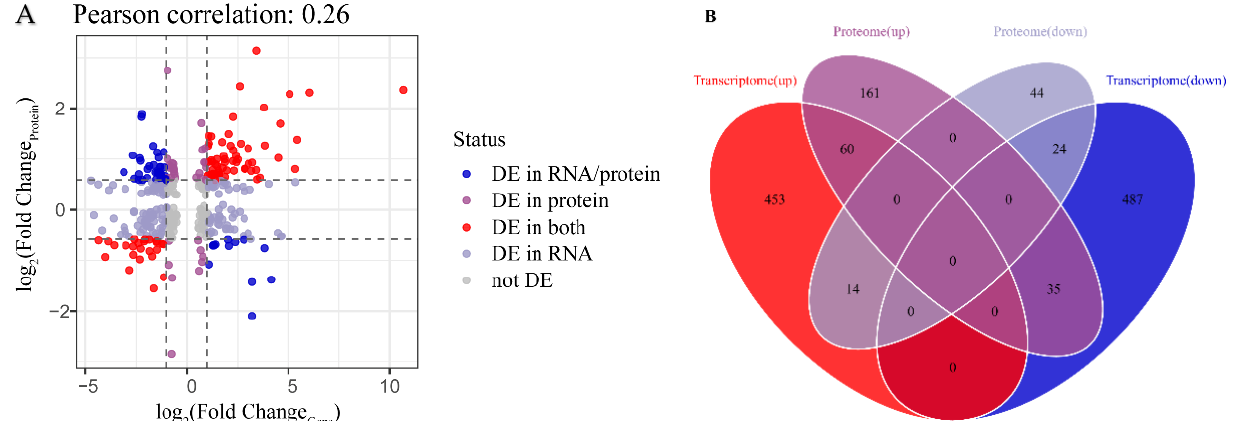
Figure 7. ( A ) Scatter diagram illustrating the relationship between differentially expressed genes and proteins quantified in transcriptomic and proteomic data sets. DE, differential expression. ( B ) Venn diagram showing the overlap of the differentially expressed genes and proteins.